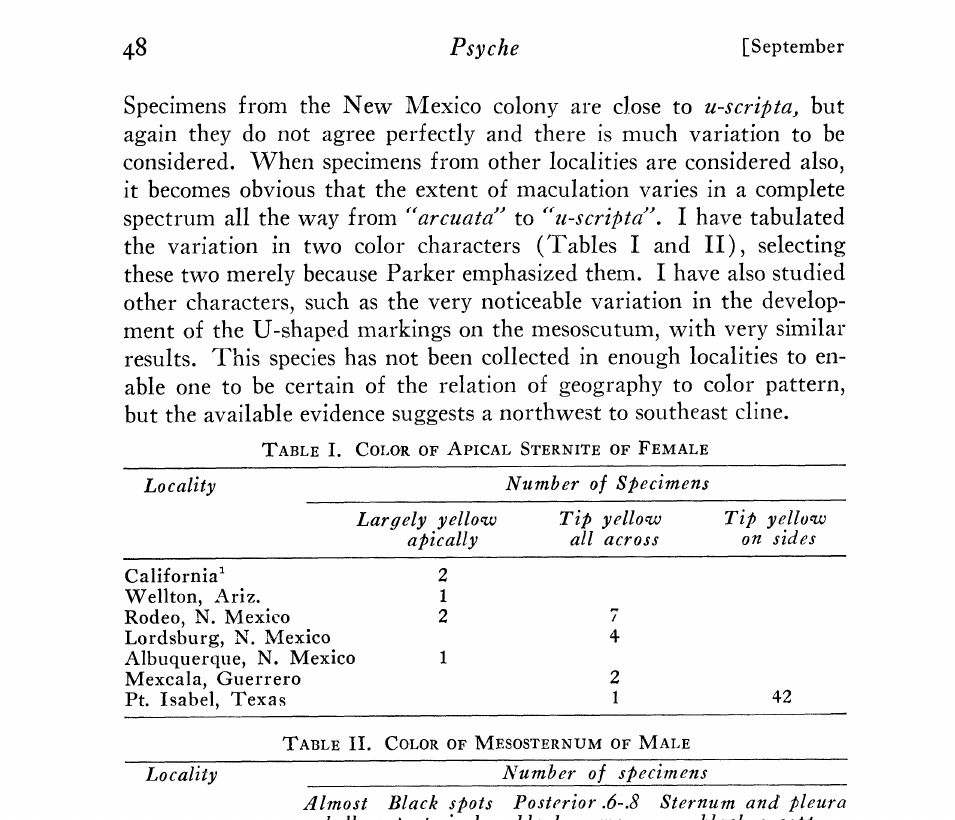
TABLE II. COLOR OF MESOSTERNUM OF MALE Locality Number of specimens Almost Black spots Posterior.6-.8 Sternum and’ pleura wholly posteriorly black, some black except yelloo on pleura anterior